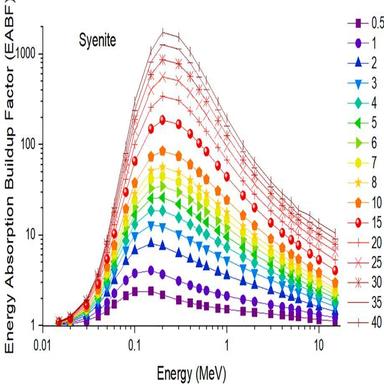
Variation of energy absorption buildup factor (EABF) values of syenite as a function of photon energy (MeV).